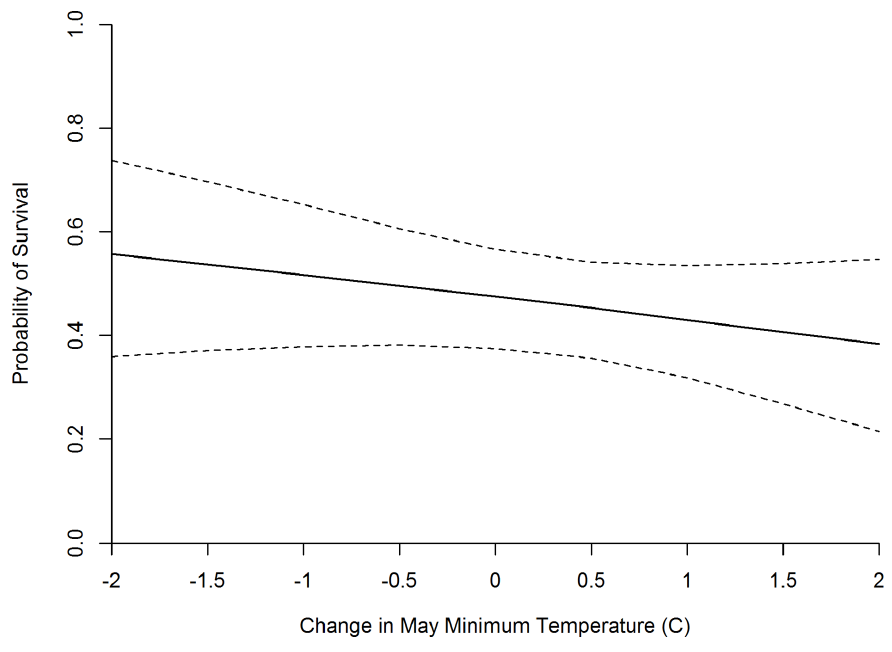
Figure 3. Effects of May minimum temperature on the probability of greater sage-grouse chick survival to 42 days of age. Dashed lines indicate 95% confidence intervals. A change of 0.0 is equal to the mean May minimum temperature observed during the extent of this study.